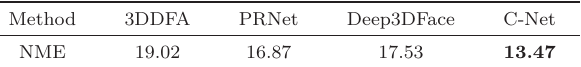
Table 2 Profile landmark localization result (%) for faces from Session 1 of Multi-PIE with large pose variations [ ± 60 ◦ , ± 90 ◦ ]. Results are mean error normalized by nose length Method 3DDFA PRNet